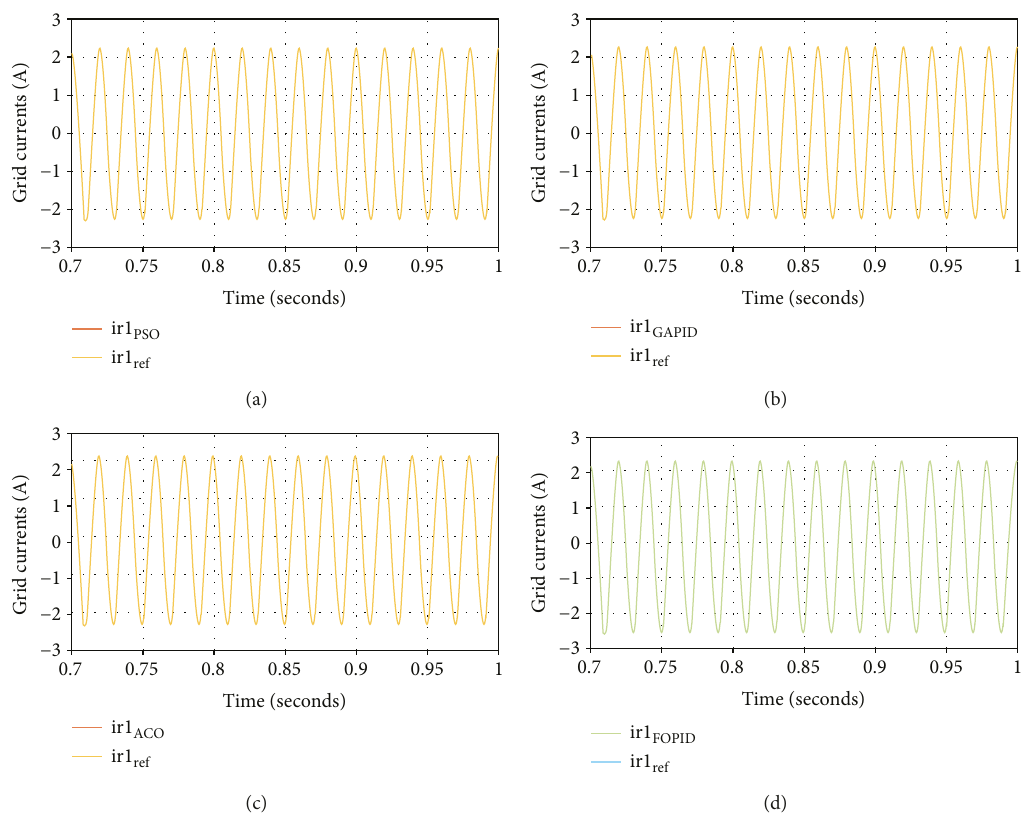
Figure 18: Voltage dip e ff ect on grid currents with limitation by using (a) PSO-PID; (b) GA-FOPID; (c) ACO-PID; (d)